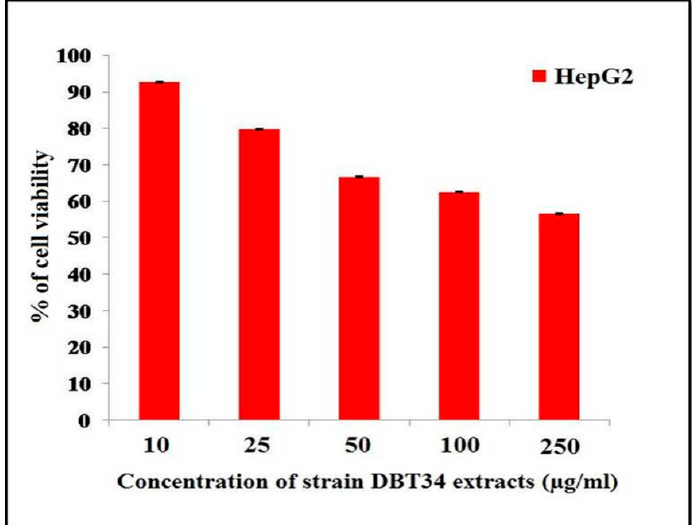
Figure 4. Effect of a 250 µg/mL methanolic extract of Streptomyces sp. strain DBT34 on the percentage Figure 4. E ff ect of a 250 µ g / mL methanolic extract of Streptomyces sp. strain DBT34 on the percentage of cell viability of HepG2 cancer cells. Each bar represents the mean ± SD. of cell viability of HepG2 cancer cells. Each bar represents the mean ±